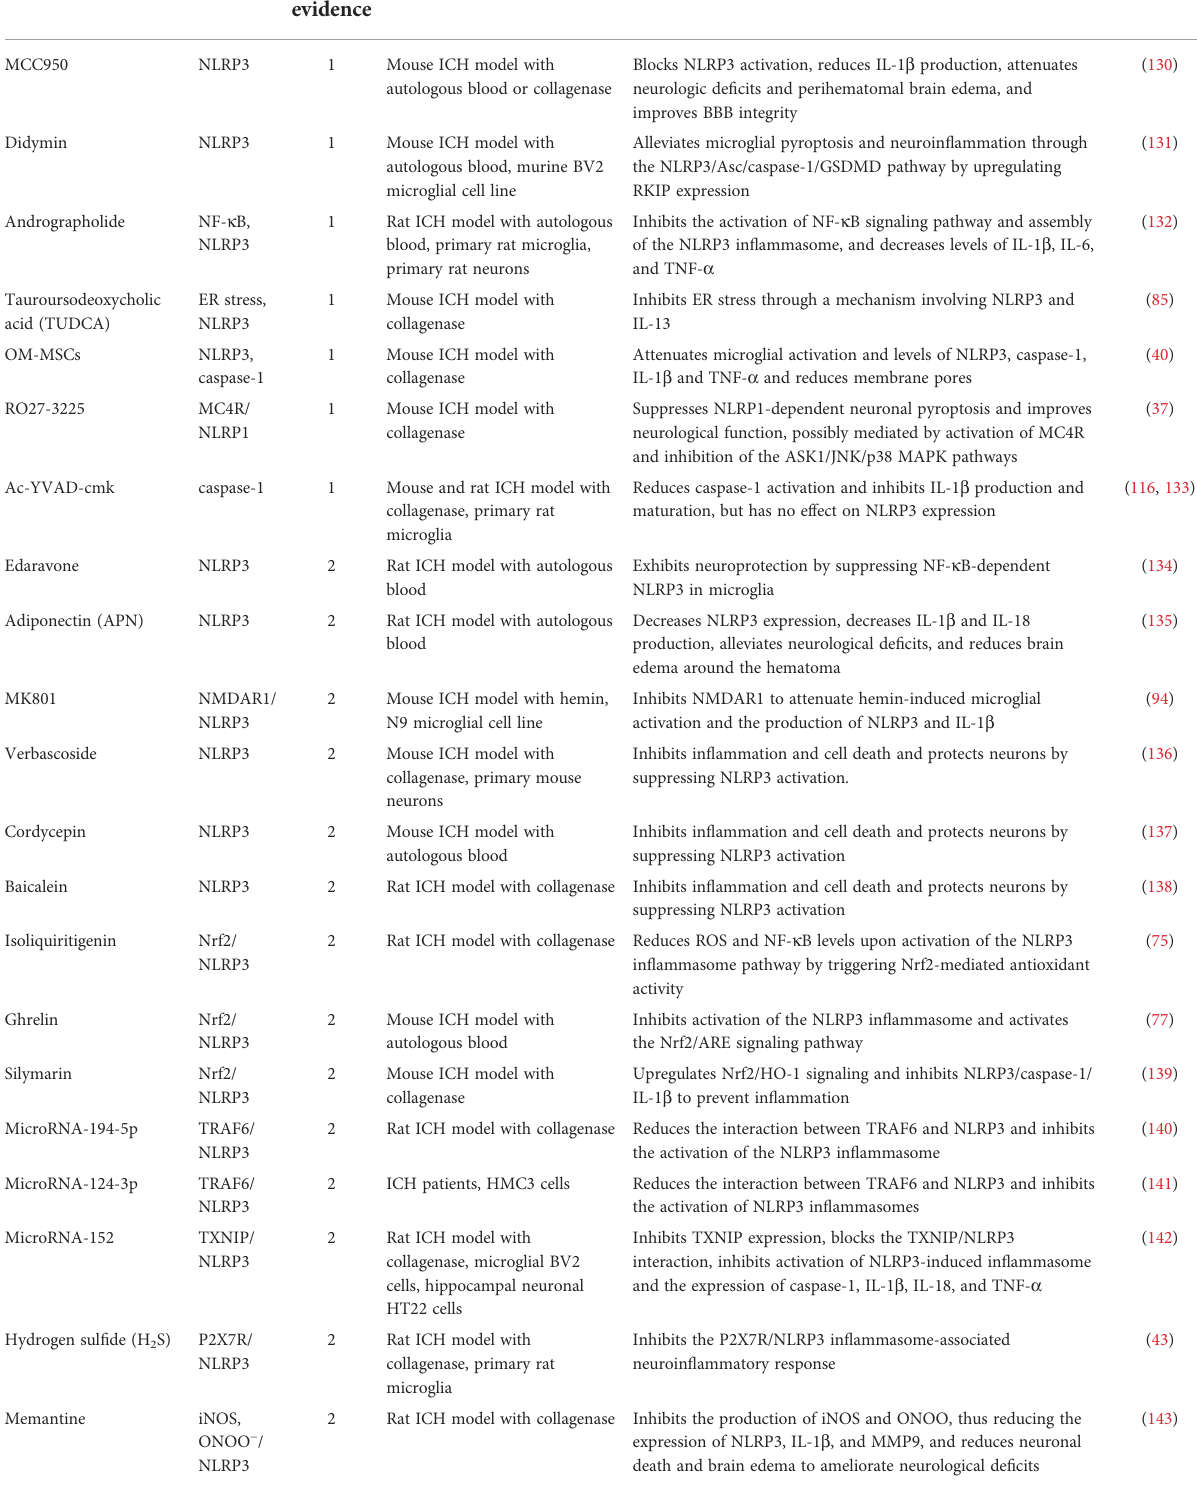
TABLE 1 Potential therapeutic drugs and targets for pyroptosis after